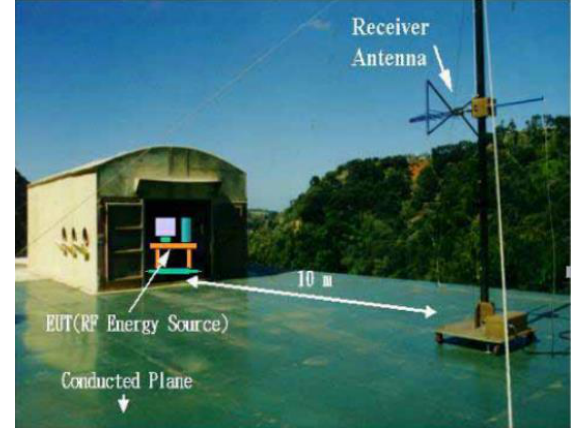
Figure 9. Schematic diagram of the open site.